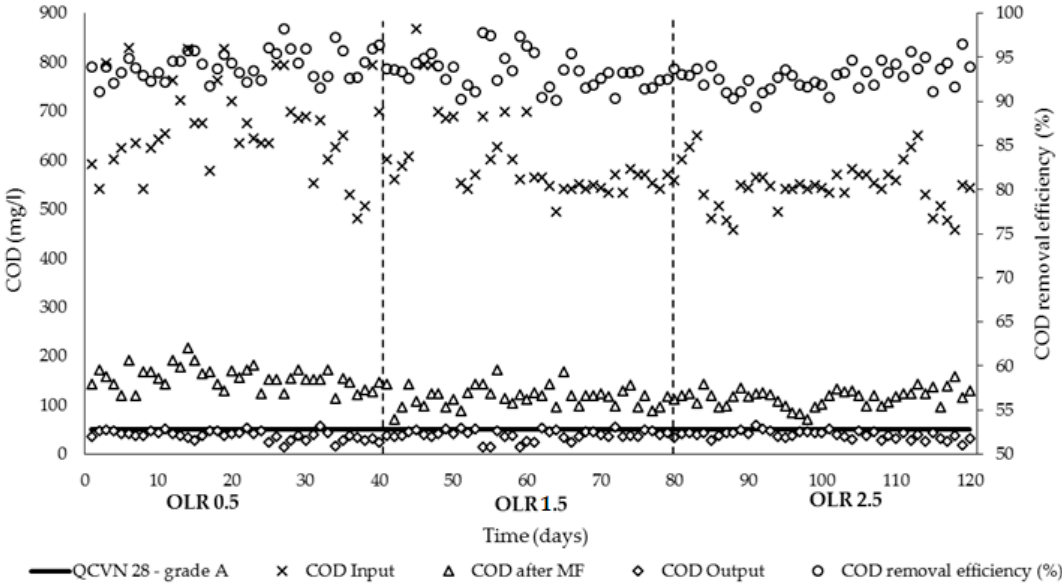
Figure 4. The chemical oxygen demand (COD) removal efficiency at three organic load rates of the MBR-NF system.